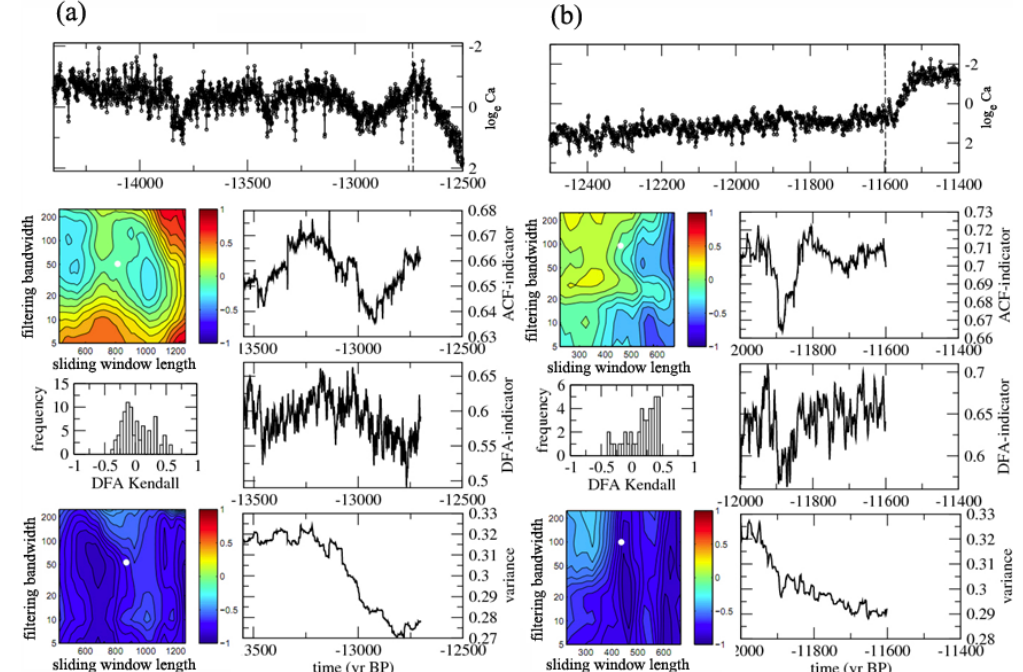
Fig. 9. Indicators of slowing down and changing variance in annual resolution GRIP ice core log e Ca records of (a) the Bølling-Allerød and (b) the Younger Dryas. Panel descriptions as in Fig.